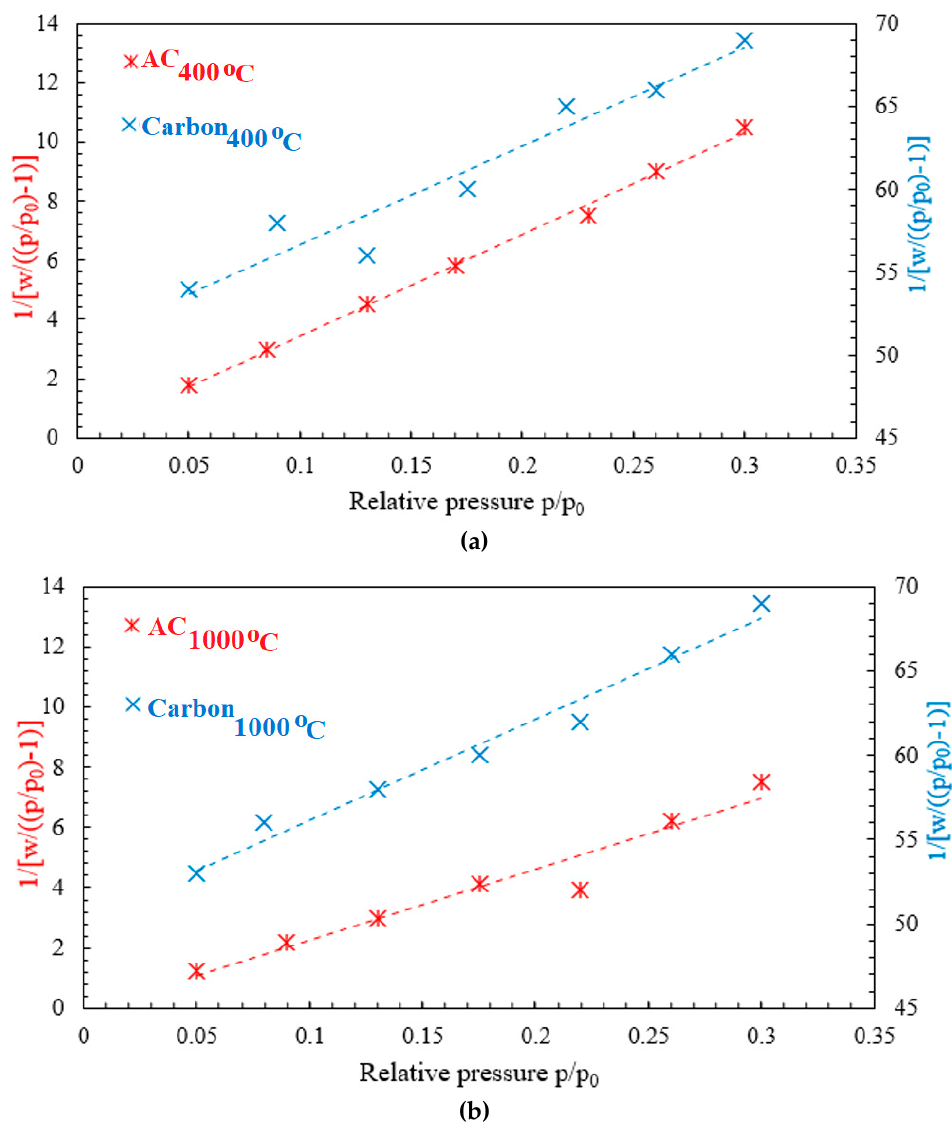
Figure 8. BET analysis for ( a ) carbon at 400 °C and activated carbon at 400 °C, and ( b ) carbon at 1000 °C and activated carbon at 1000